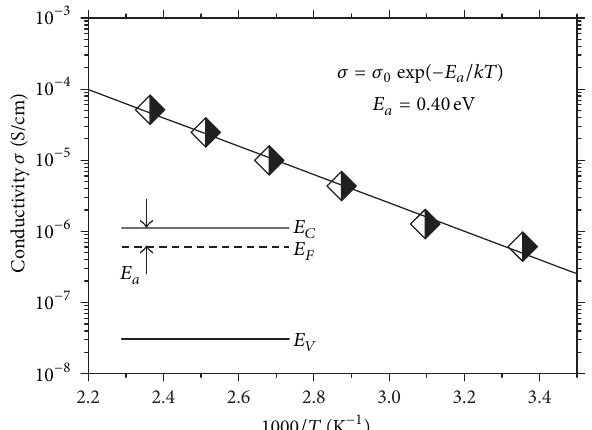
Figure22:Temperaturedependenceoftheelectricalconductivityin low resistance state in Pt/ZnO/Pt memory devices. The inset graph shows the location of Fermi level in ohmic